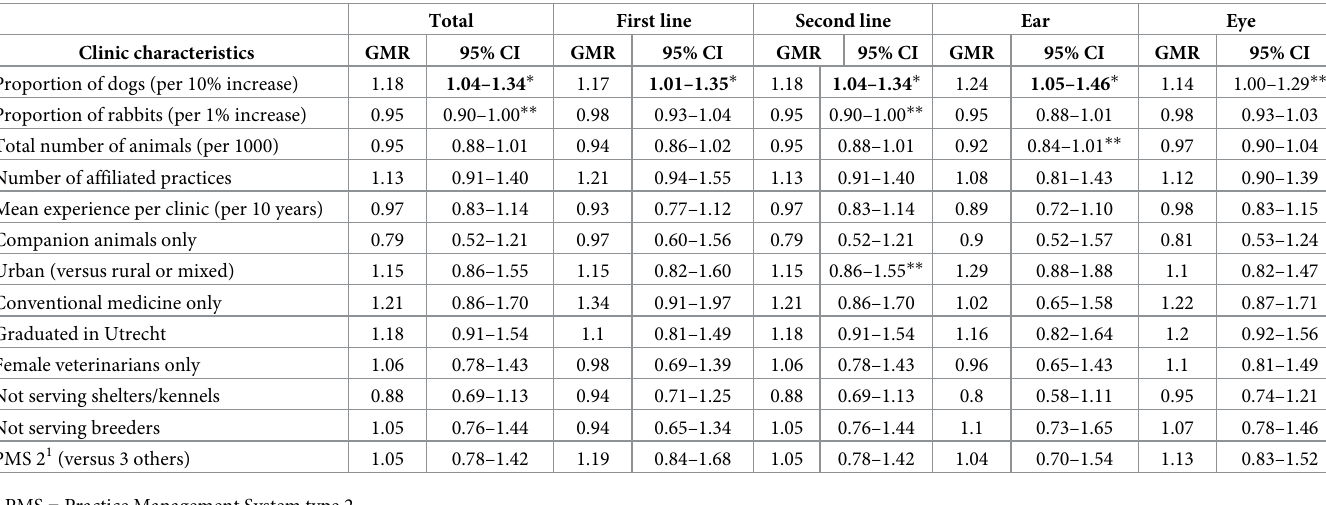
Table 2. Effect estimates for potential determinants of topical AMU. The results are the output of a multivariable regression model for total, first line, second line topi- cal AMU and ear and eye product AMU. The data are log-transformed. Total